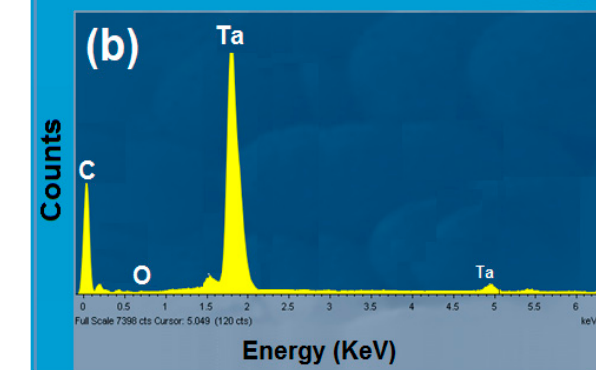
Figure 5. SEM surface micrograph ( a ) and EDS spectrum ( b ) for TaC coating.